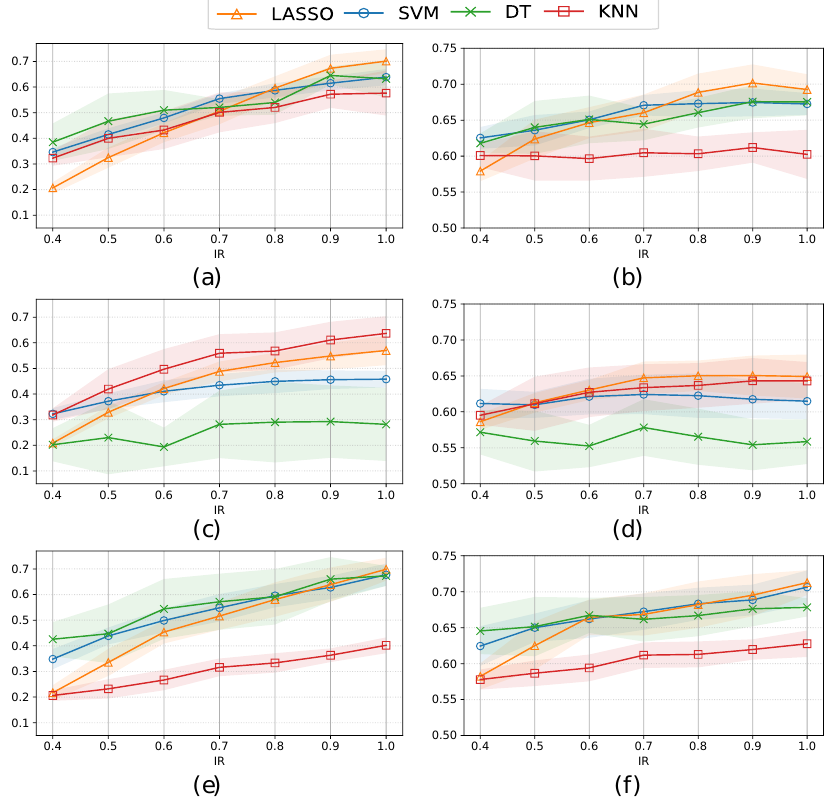
Figure 5. Mean ± std of the sensitivity (left panels) and AUC (right panels) considering 5 test subset partitions and different IR values, classifiers (LASSO, SVM, DT and KNN) and an oversampling approach with: ( a , b ) SMOTEN; ( c , d ) TVAE; and ( e , f )